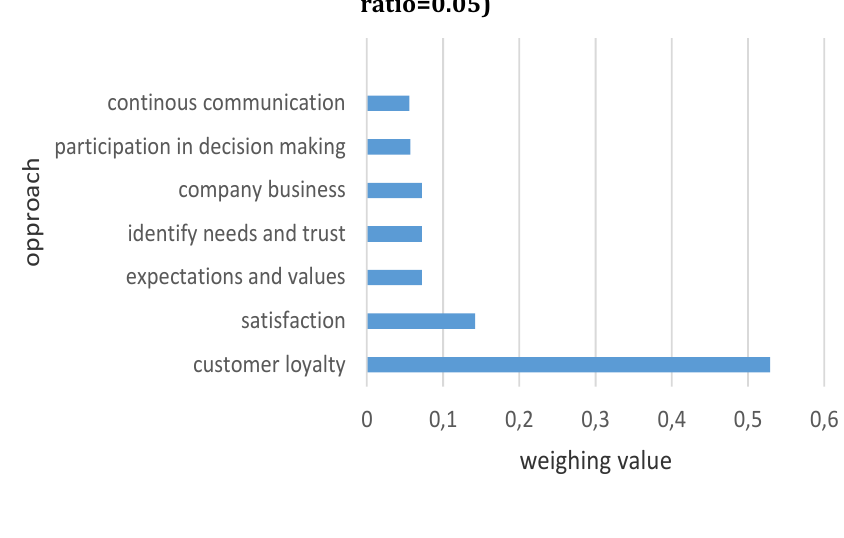
Figure 6: Result of customer’s approach sub criteria weighing value